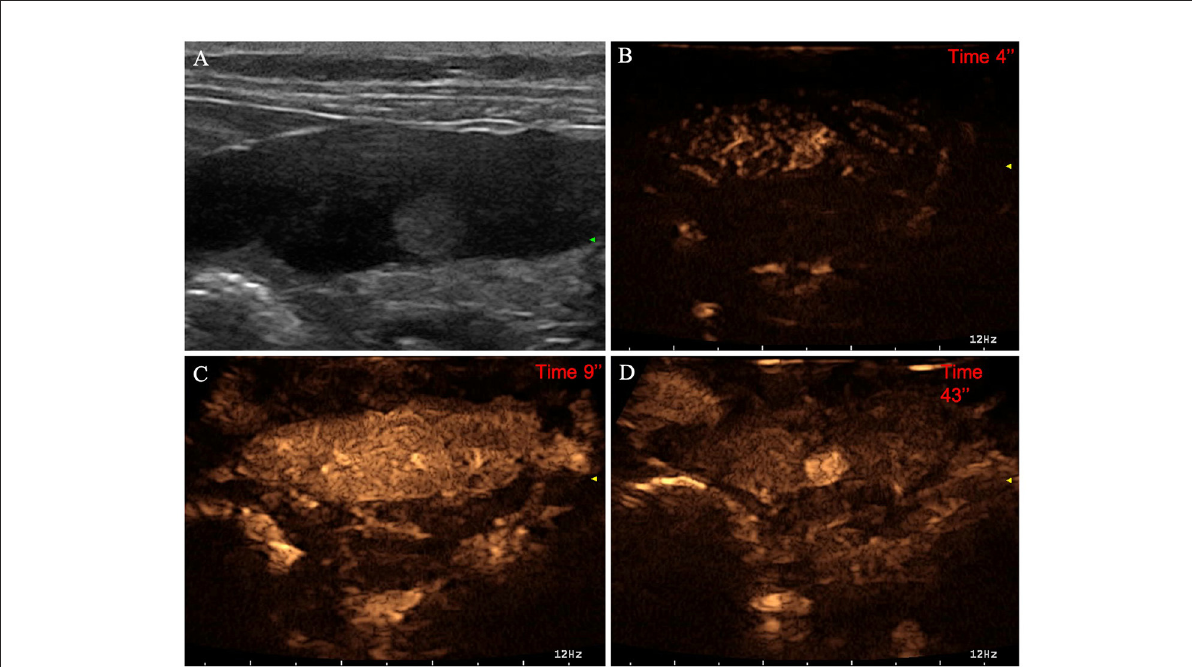
FIGURE7 Example of an insulinoma (OML) showing: no pseudocystic appearance, hyperechogenicity, absence of acoustic enhancement, and presence of peripancreatic reactivity at US; hyperenhancement, diffused and homogeneous distribution of contrast medium, absence of intralesional microcirculation, and absence of hypoperfused areas during wash-in at CEUS; no wash-out. (A) Image obtained from US examination; (B) image obtained at TTE; (C) image obtained at TTP; (D) image obtained during